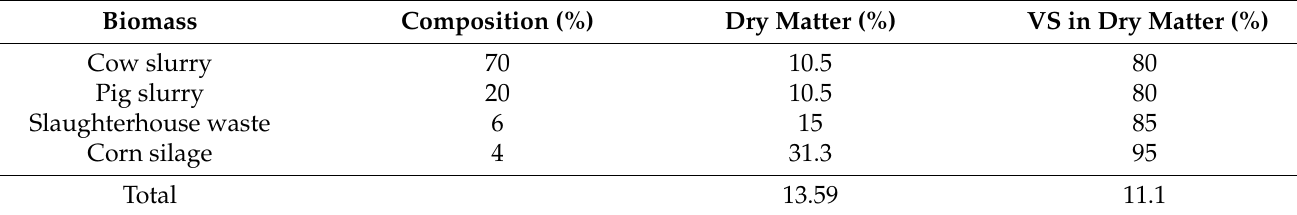
Table 1. Composition and share of organic matter of the processed biomass. Numbers are based on Linke et al. [21] and Olesen et al. [22] and aligned to specific values reported for the plant. The last row is reporting the average value for the share of dry matter (DM) considering the composition, as well as the average values for the share of volatile solids (VS) considering the composition and the share of